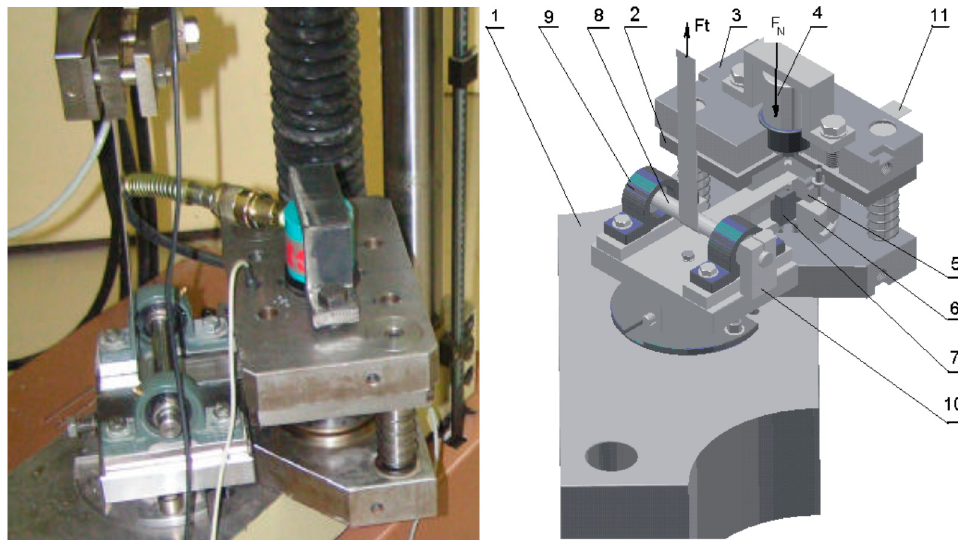
Figure 3. The friction simulator photo and CAD model—strip drawing test. 1—base plate; 2— middle plate; 3—upper plate; 4—hydraulic clamping cylinder; 5—upper grip; 6—lower grip; 7— dynamometer for measurement of blankholding force; 8—roller; 9—ball bearings; 10— brake mechanism of the roller; 11-strip.